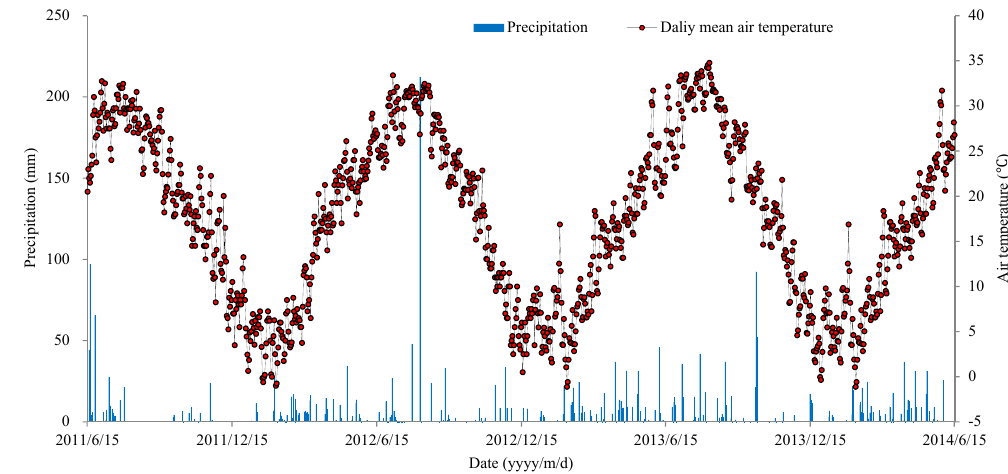
Figure 1. Daily mean air temperature and precipitation during the rice-wheat rotation in 2011–2014 in Changshu, China.